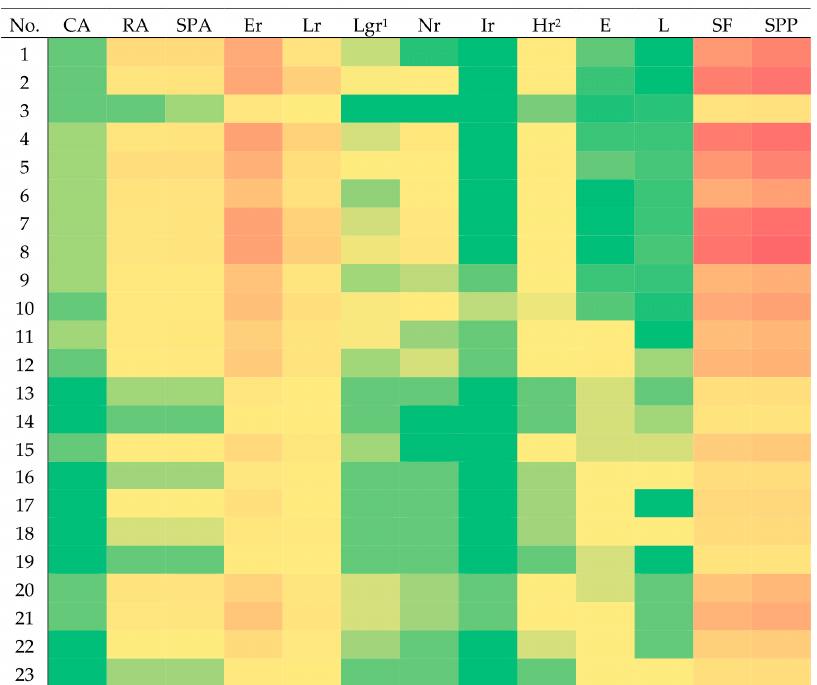
Figure 5. Heatmap of content of determined polyphenolic compounds in peppermint tinctures. CA, caffeic acid; RA, rosmarinic acid; Er, eriocitrin; Lr, luteolin rutinoside; Lgr, luteolin glucuronide (luteolin glucuronide + luteolin glucoside calculated as Lgr); Nr, narirutin; Ir, isorhoifolin; Hr, hesperidin (hesperdin + diosmin calculated as Hr); E, eriodictyol; L, luteolin; SPA, sum of polyphenolic acids; SF, sum of flavonoids; SPP, sum of polyphenols; higher concentration: red, lower concentration: green.